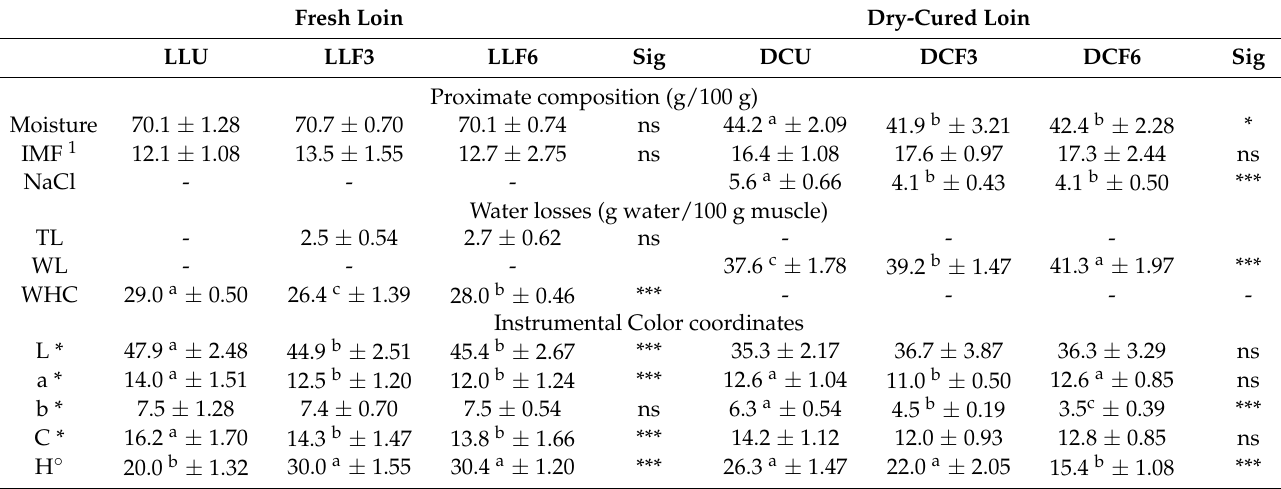
Table 1. Effect of freezing and pre-freezing cure on proximate composition, water losses, and instrumental colour. Fresh Loin Dry-Cured Loin